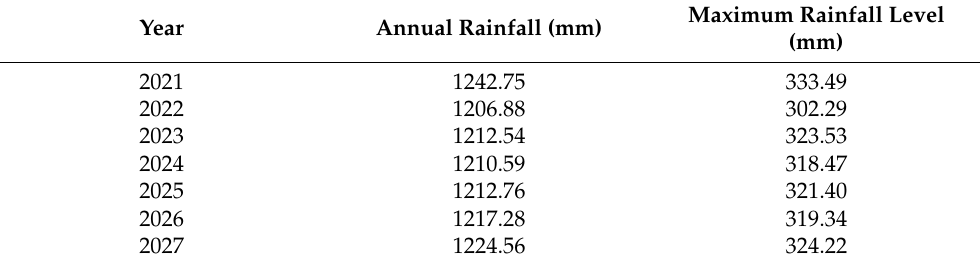
Table 3. Future rainfall forecast, along with intensity.